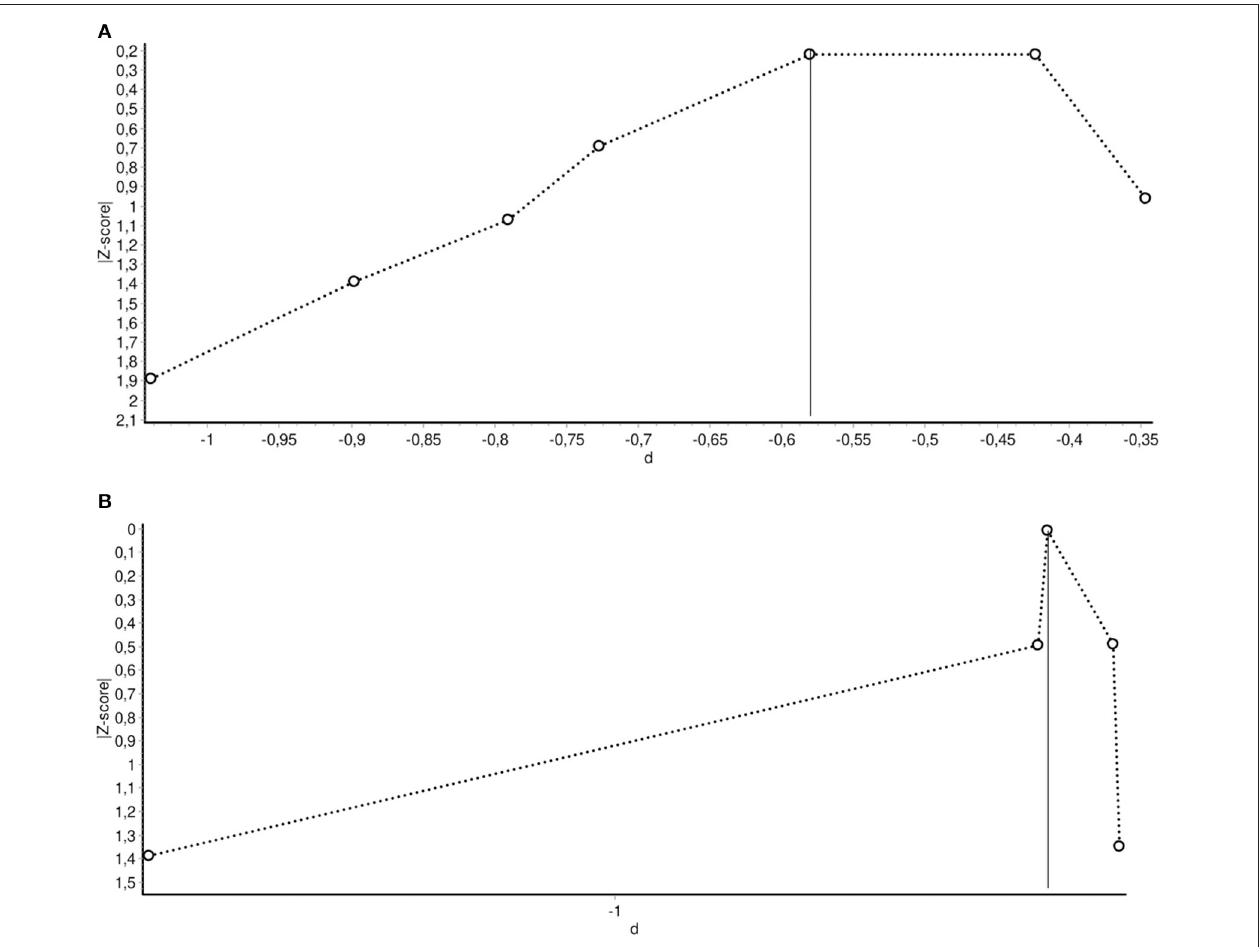
FIGURE 4 | (A) Doi plot for the assessment of publication bias in studies assessing short-term effects of interventions in reducing depressive symptoms. LFK index: − 2.56 (major asymmetry). (B) Doi plot for the assessment of publication bias in studies assessing mid-term effects of interventions in reducing depressive symptoms. LFK index: − 1.10 (minor